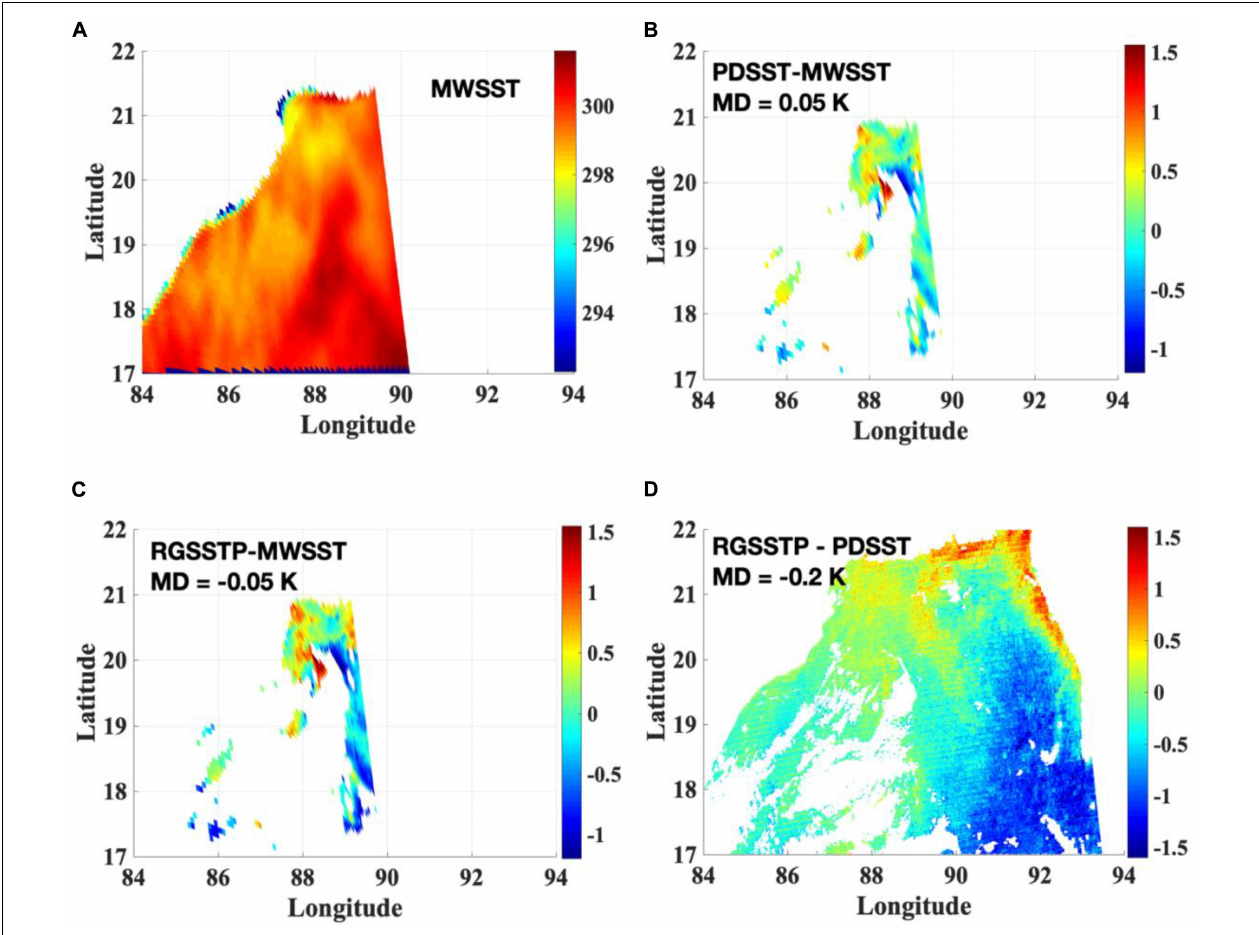
FIGURE 7 | SST retrieval maps for the same subset as in Figure 6A . (A) MWSST from AMSR2, (B) Difference between PDSST and MWSST, (C) Difference between RGSSTP and MWSST, and (D) RGSSTP – PDSST. The ranges of longitude and latitude from − 180 ◦ to 180 ◦ and from − 90 ◦ to 90 ◦ represent West to East and South to North, respectively. Unit of color bar is